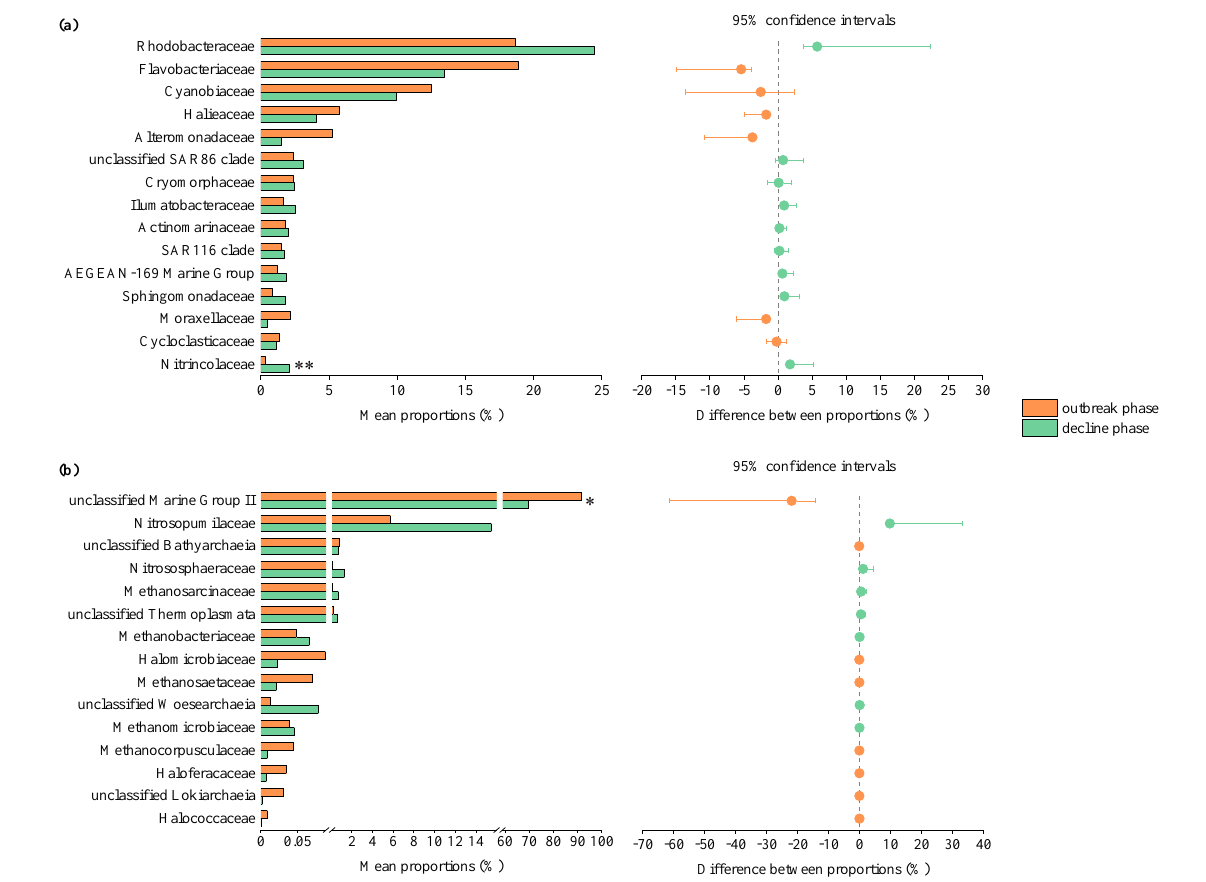
Figure 3. Principal component analysis (PCA) of bacterial ( a ) and archaeal ( b ) communities at the OTU level during the green tide.